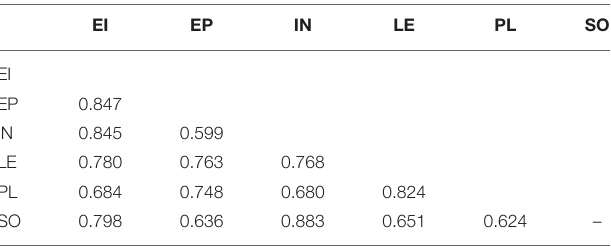
TABLE 4 | HTMT ratio of correlation.